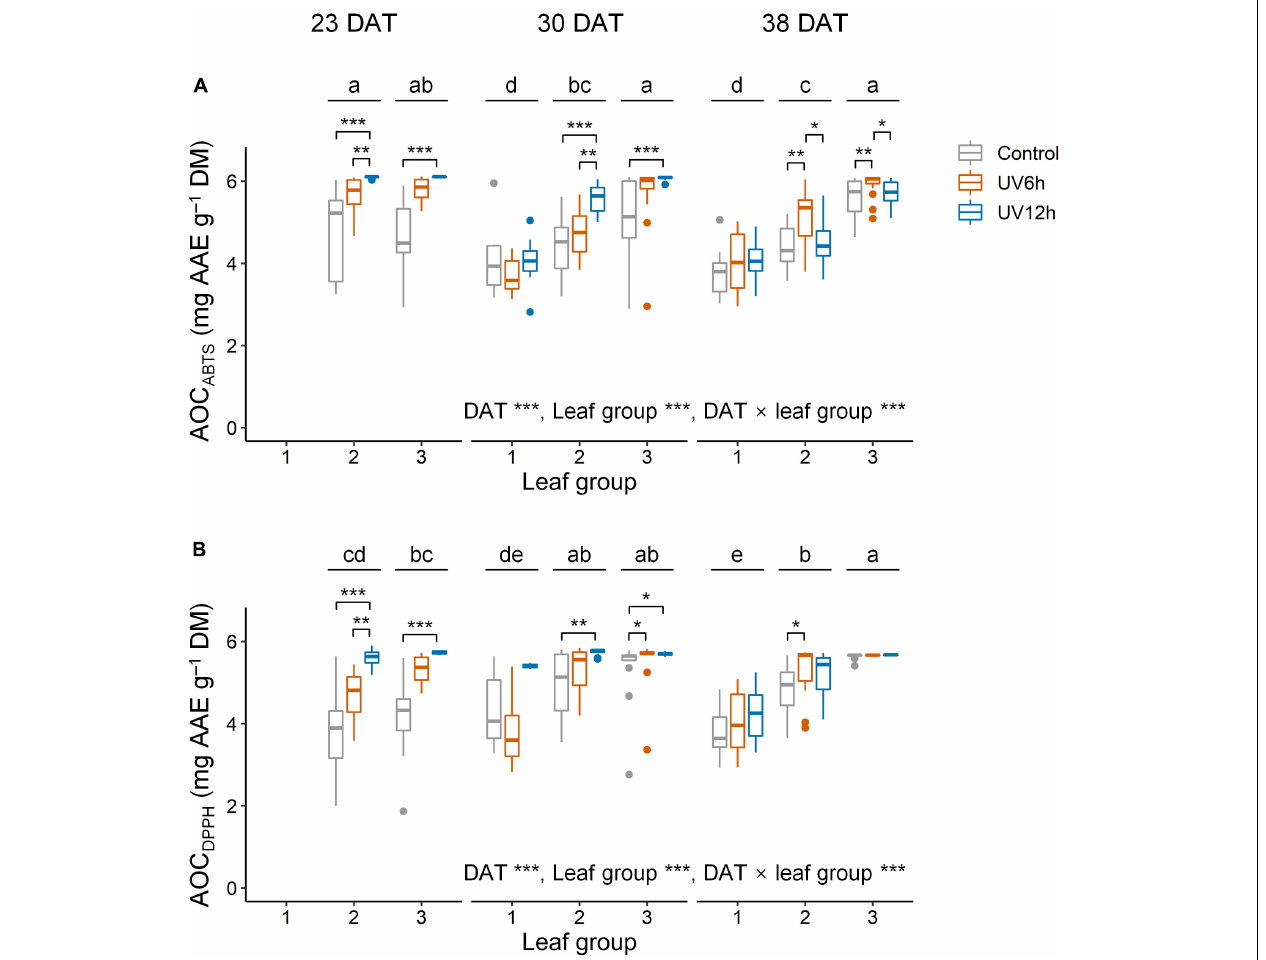
FIGURE 5 | Antioxidant capacity using ABTS (AOC ABTS , A) and DPPH assays (AOC DPPH , B) in individual leaves of kale plants according to UV-B radiation and leaf group at 23, 30, and 38 days after transplanting (DAT). Leaf groups were determined according to the order of leaf emergence and their relative growth state ( Supplementary Figure 3 and Supplementary Table 1 ). Asterisks indicate significant differences between UV-B treatments at each growth stage and leaf group by one-way ANOVA and post-hoc test, * P < 0.05; ** P < 0.01; *** P < 0.001; n = 7–22. Different letters indicate significant differences among growth stage and leaf group at P < 0.05 by two-way ANOVA and post-hoc test ( n = 22–59) referring to the “Materials and Methods” section.